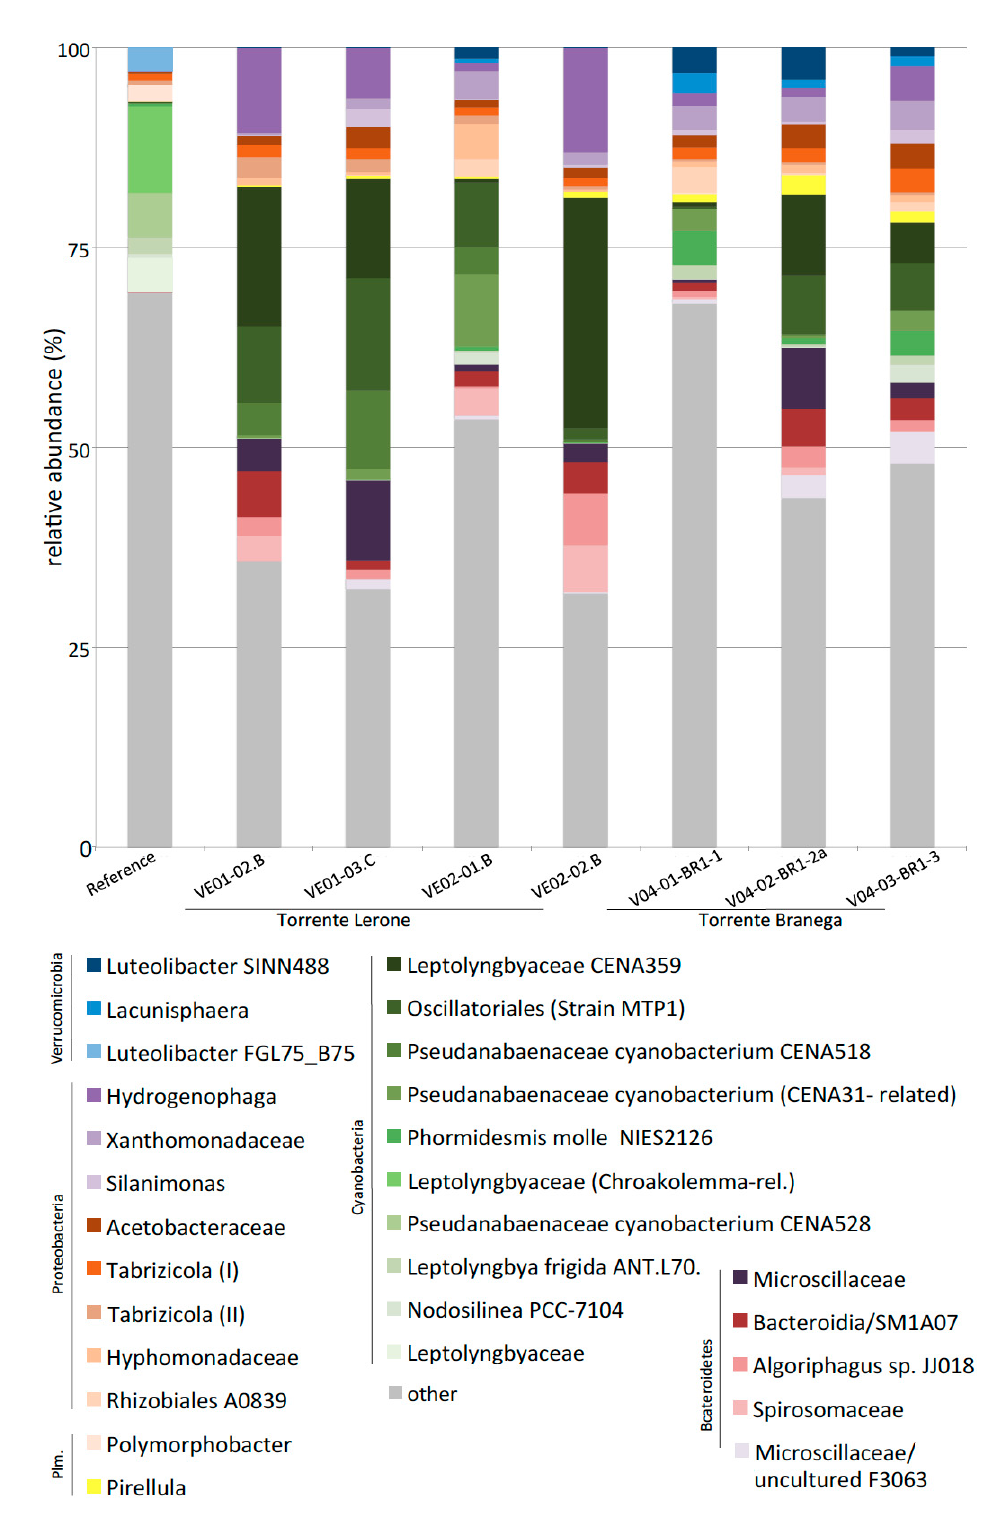
Figure 5. Bar charts showing the most abundant bacterial groups retrieved from all sites (reference: Table 1. VE02, Torrente Lerone spring site; V04, Torrente Branega spring sites).